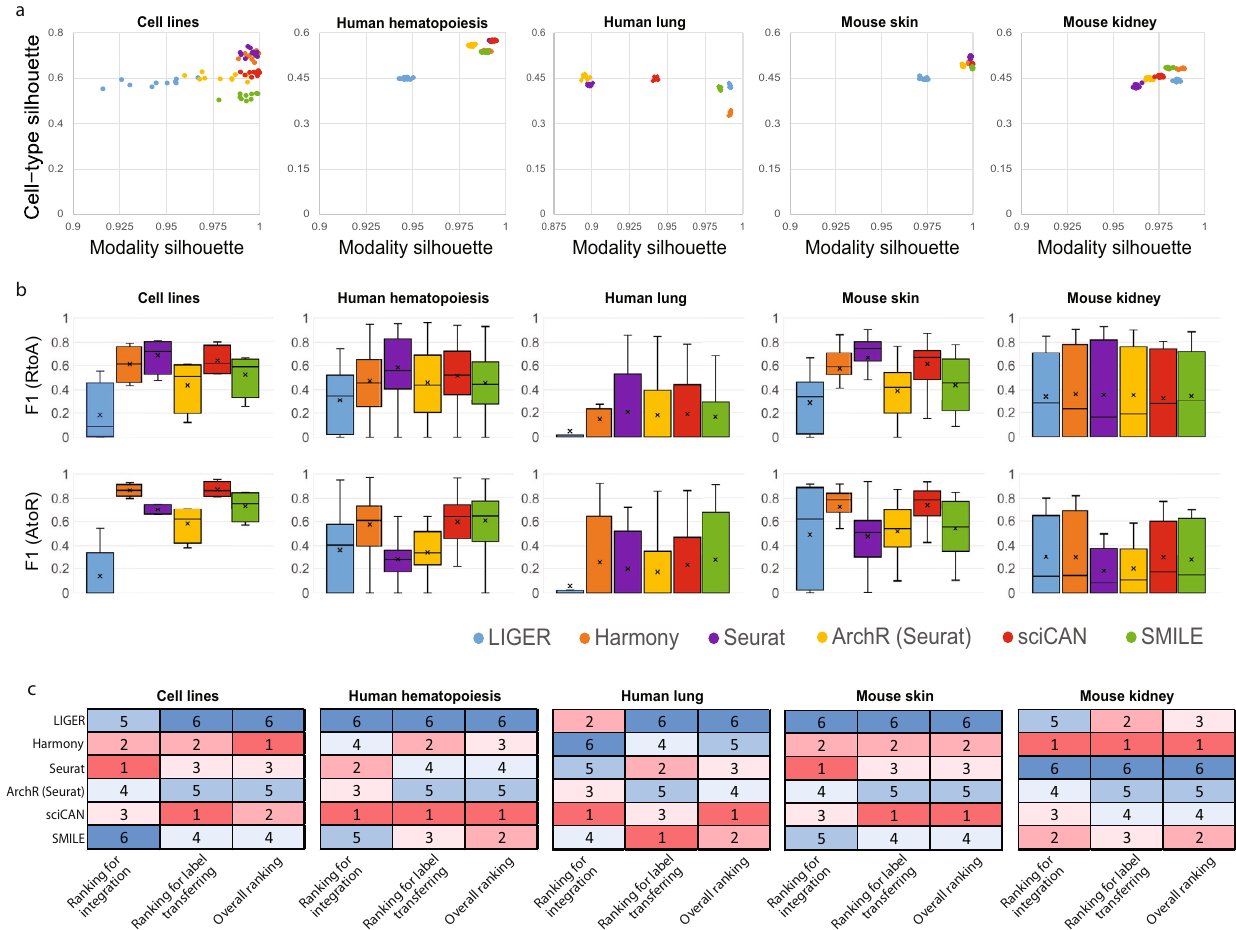
Fig. 2 Benchmarking of sciCAN against other 5 existing integration methods. a Integration evaluation by modality and cell-type silhouette scores across 5 datasets. x axis corresponds to modality silhouette score and y axis to cell-type silhouette score. Ideal integration should be located in the top right corner of each dot plot. To generate the dot plot, we randomly subsample 20% of the cell population to calculate both modality and cell-type silhouette scores for each method and each dataset. b Integration evaluation by F1 scores across 5 datasets. Upper panel corresponds to label transferring from RNA-seq to ATAC-seq (RtoA) while lower panel indicates label transferring from ATAC-seq to RNA- seq (AtoR). Boxplots are plotted based on F1 scores for all cell types in that dataset. The median value is marked with a horizontal line within the box, and the “ X ” mark represents the macro F1 score, which is the average of F1 scores for all cell types. Whiskers show minimum and maximum value and top and bottom of the box show 25th and 75th percentile respectively. c Benchmark ranking across 5 datasets. In each category, methods are ranked based on their scores from best (red, low number ranking) to worst (blue, high number